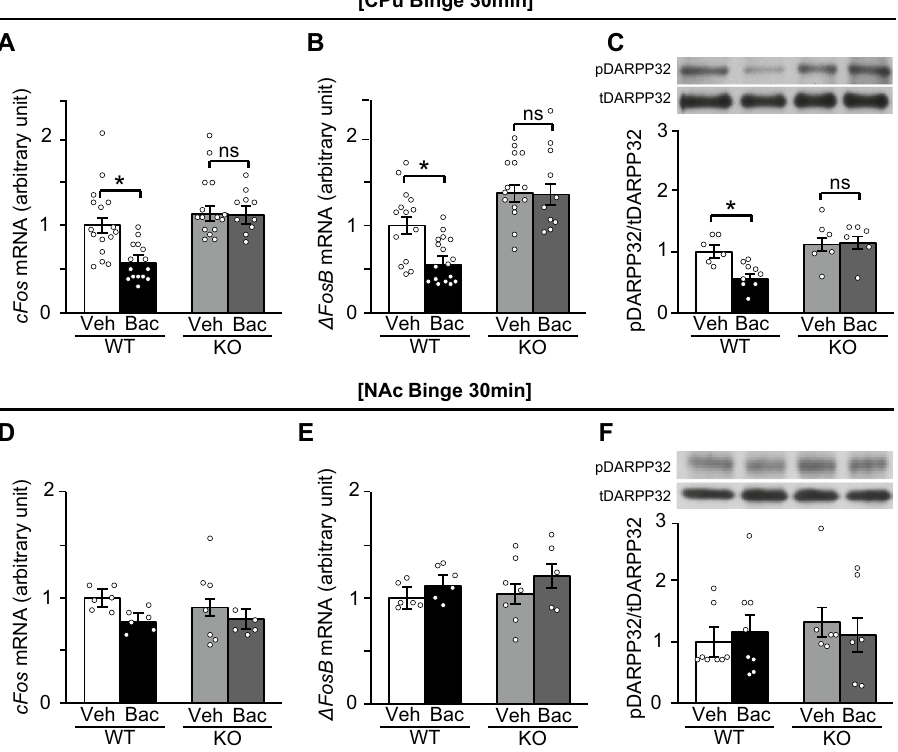
Figure 5. Suppressive effects of baclofen on cFos and ΔFosB mRNA expression levels as well as phosphorylation of DARPP32 in the CPu were absent in KO mice. ( A – C ) The mRNA expression levels of cFos (A) and ΔFosB ( B ), and phosphorylation of dopamine- and cyclic-AMP–regulated phosphoprotein of molecular weight 32,000 (DARPP32) protein ( C ) in the caudate putamen (CPu) in wild-type (WT) and knockout (KO) mice of a binge group on a high fat diet (HFD) treated with vehicle and baclofen. ( D – F ) The mRNA expression levels of cFos ( D ) and ΔFosB ( E ), and phosphorylation of DARPP32 ( F ) in the nucleus accumbens (NAc) in WT and KO mice of a binge group treated with baclofen and vehicle. All values are mean ± SEM. Statistical analyses were performed using two-way factorial analysis of variance (ANOVA) followed by Sidak’s post-hoc test ( A – F ). ns: not significant, veh: vehicle, bac: baclofen. * p < 0.05 versus vehicle in WT mice. See also Supplemental Table 2 for details on